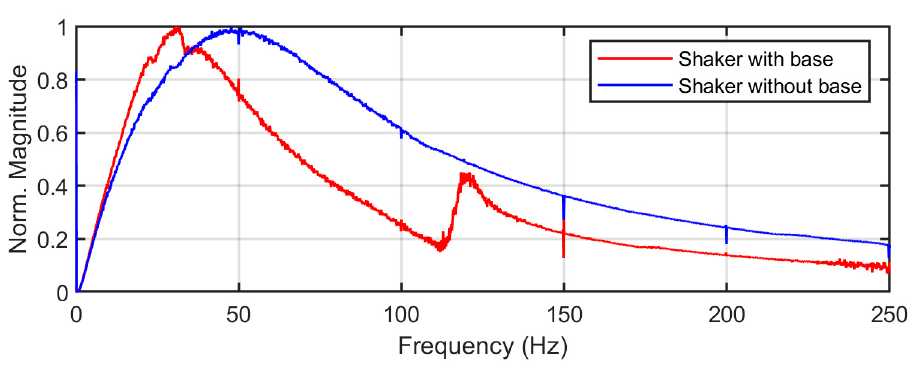
Figure 18. Frequency response of the base velocity relative to the input signal generator.